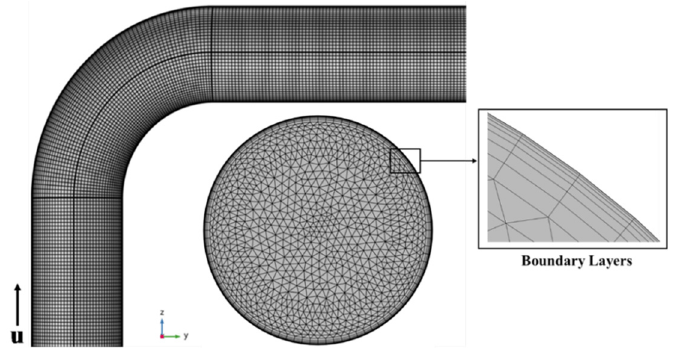
Figure 3. Mesh distribution arrangement of pipeline and two ‐ phase inlet.